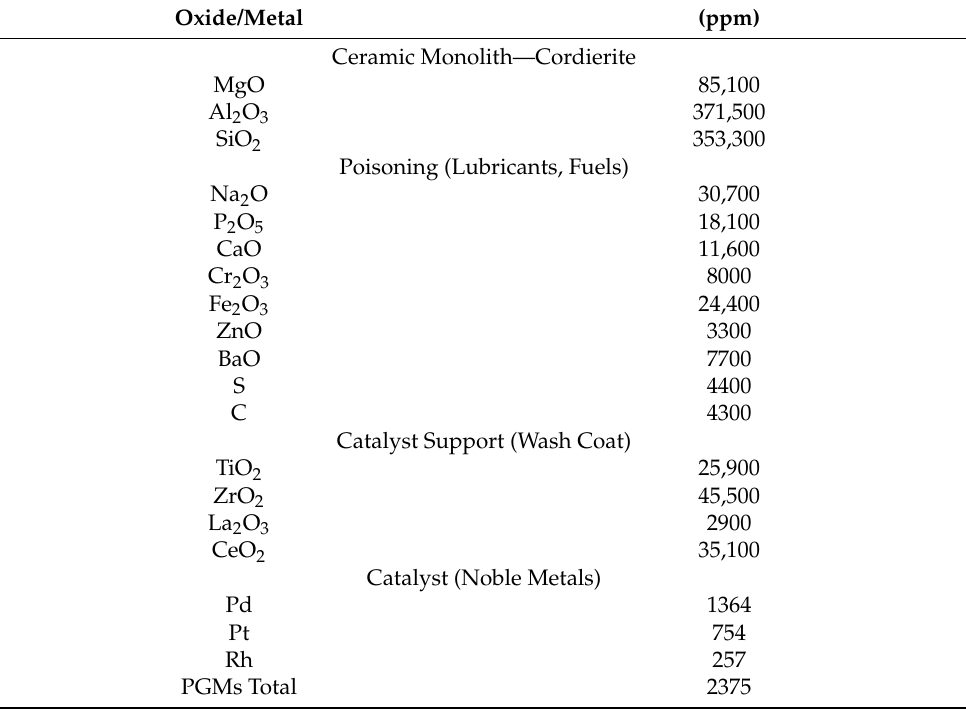
Table 2. Chemical analysis of a spent ceramic honeycomb catalytic converter [33]. Oxide/Metal (ppm) Ceramic